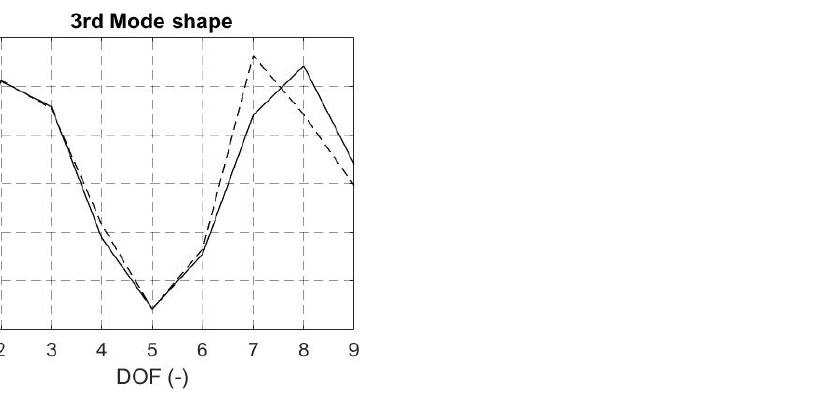
Figure 19. Mode shapes of the free beam (the solid line is EMA identification result, the dotted line is ERA/DC identification result).